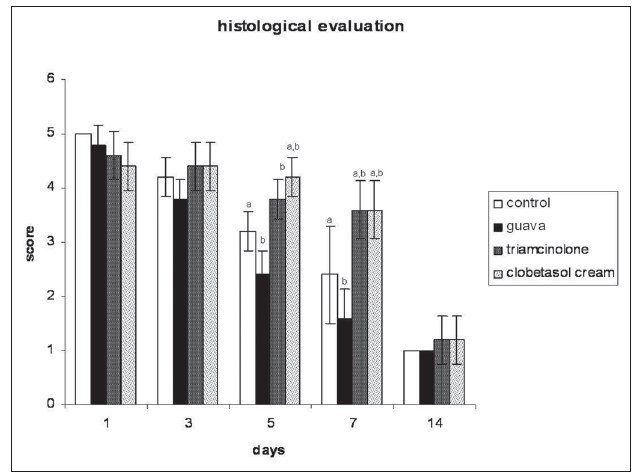
Fig. 3. Histological analysis (scores) of the four experimental groups. Same letters indicate statistically significant difference among groups.